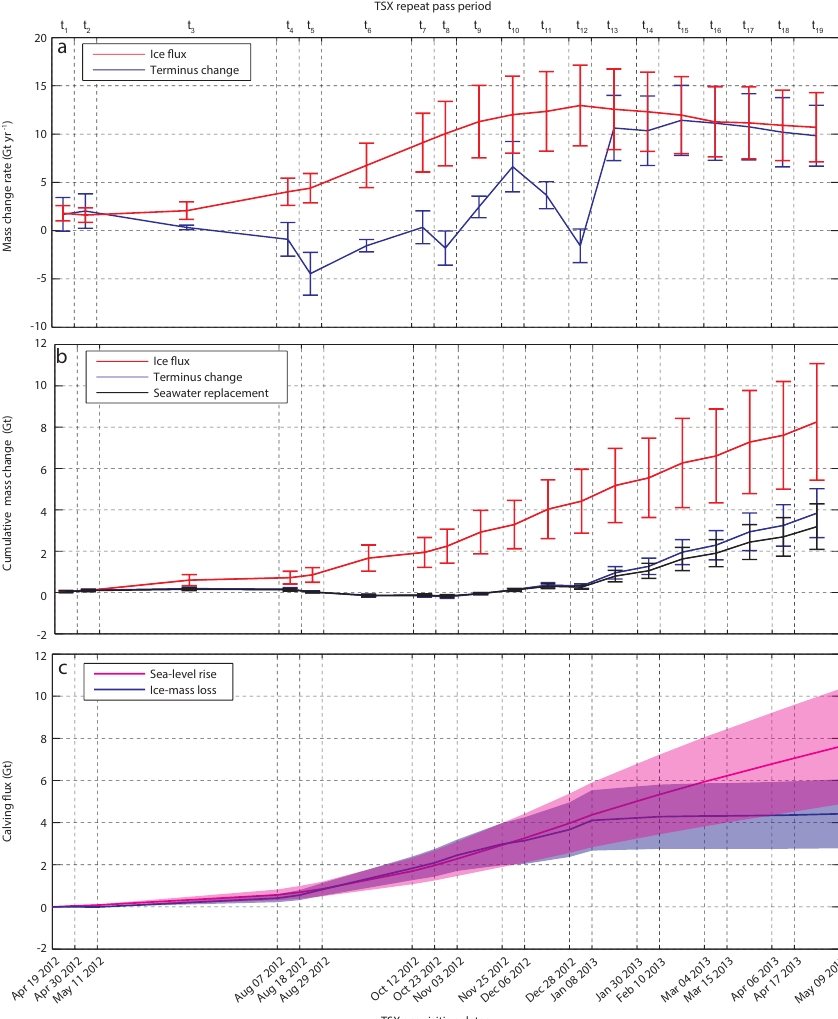
Figure 4. Calving flux from Basin-3, Austfonna, April 2012 to May 2013. Calving components are expressed in terms of the instantaneous (a) and cumulative mass change (b) and allocated to the effect on glacier mass balance and sea level ( c ) (see Sect. 4.3). Whiskers in (a, b) indicate uncertainty bounds calculated using propagation-of-uncertainty analysis, and shaded areas in (c) indicate upper and lower bounds given maximum or minimum ice thickness.